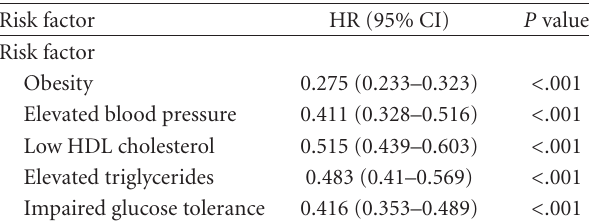
Table 3: Multivariate analysis of hazard risks concerning reverse clustering of CVD risk factors after 5